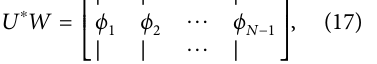
Frontiers in Energy Research |